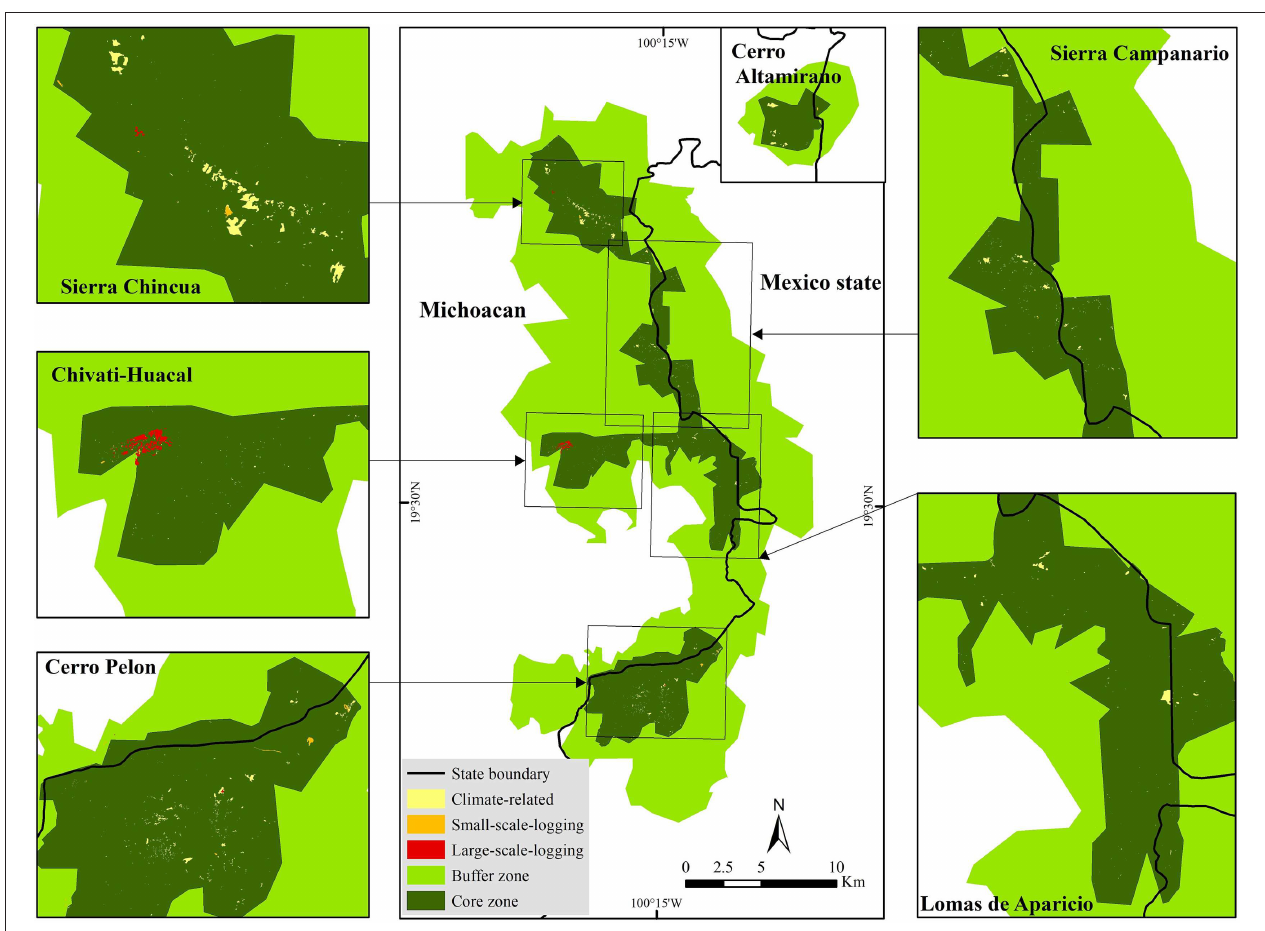
FIGURE 3 | Maps depicting forest cover loss due to climate-related factors (yellow), and large-scale (red), and small-scale (orange) illegal logging in the core zones of the MBBR (light green and dark green). Forest cover loss includes from 2012 to 2018.